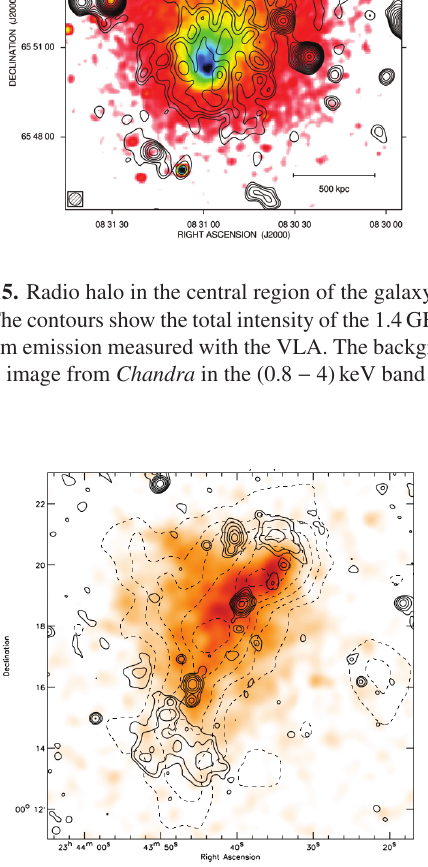
Figure 16. Pair of radio relics at the outskirts of the merging galaxy cluster ZwCl2341.1 + 0000. The contours show the to- tal intensity of the 610MHz radio continuum emission measured with the GMRT. The background is an X-ray image from Chan- dra in the (0 . 5 − 3)keV band [54].